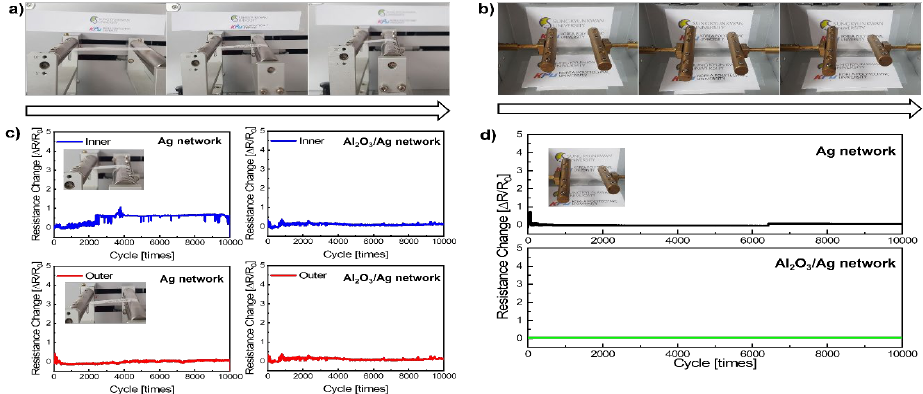
Figure 4. ( a ) Photographs of the rolling test procedure. ( b ) Photographs of the twisting test proce- dure. ( c ) Results of the repeated inner/outer rolling test of Ag and Al 2 O 3 /Ag network electrodes. ( d ) Results of the repeated twisting test of Ag and Al 2 O 3 /Ag network electrodes.